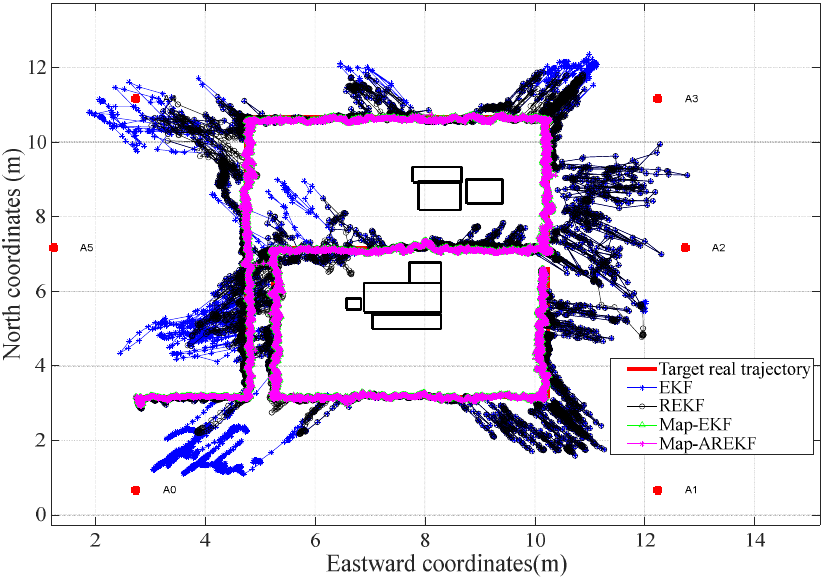
Figure 24. Experiment 3 results of 4 localization algorithms solved when using 0.2 m interval information maps.